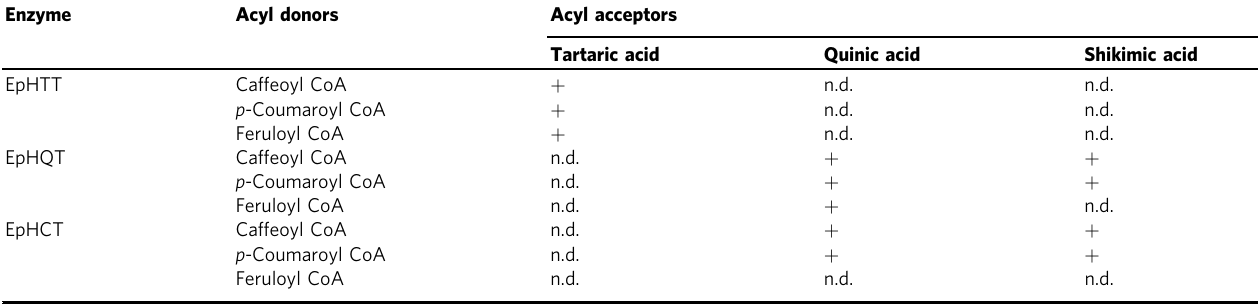
Table 1 EpBAHD substrate preferences.